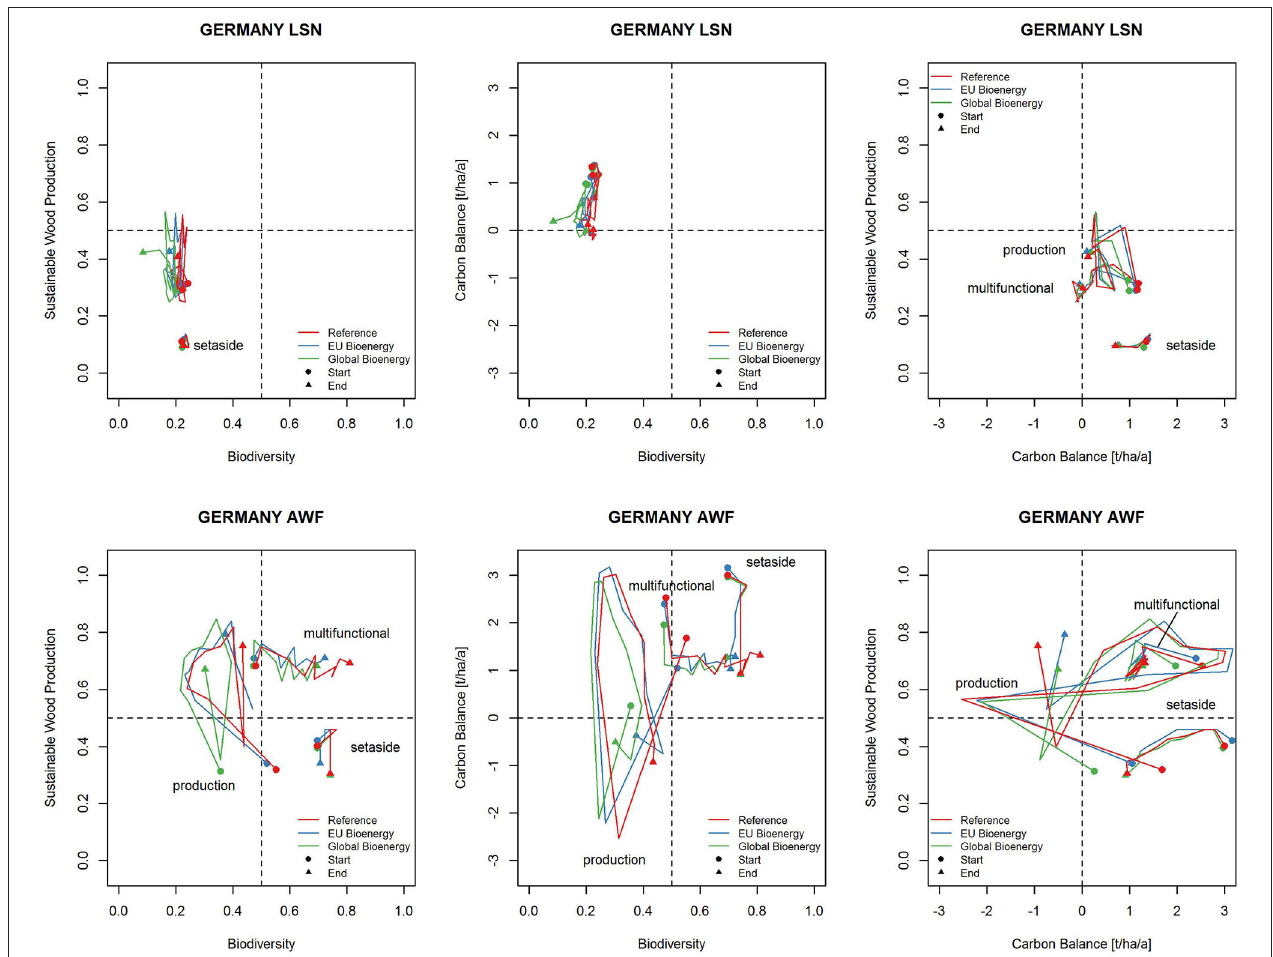
FIGURE 6 | Trade-off diagrams for the two German case studies. Upper panel: Northeast German case study “Lieberose-Schlaubetal, Neuzelle” (LSN). The trajectories of the “set aside” scenarios are labeled in the left and rightmost diagram. In the latter, also the multifunctional and production scenarios are marked. Lower panel: Southern German case study “Augsburg Western Forests” (AWF). The trajectories of all three silvicultural scenarios (multifunctional, production, and set aside) are